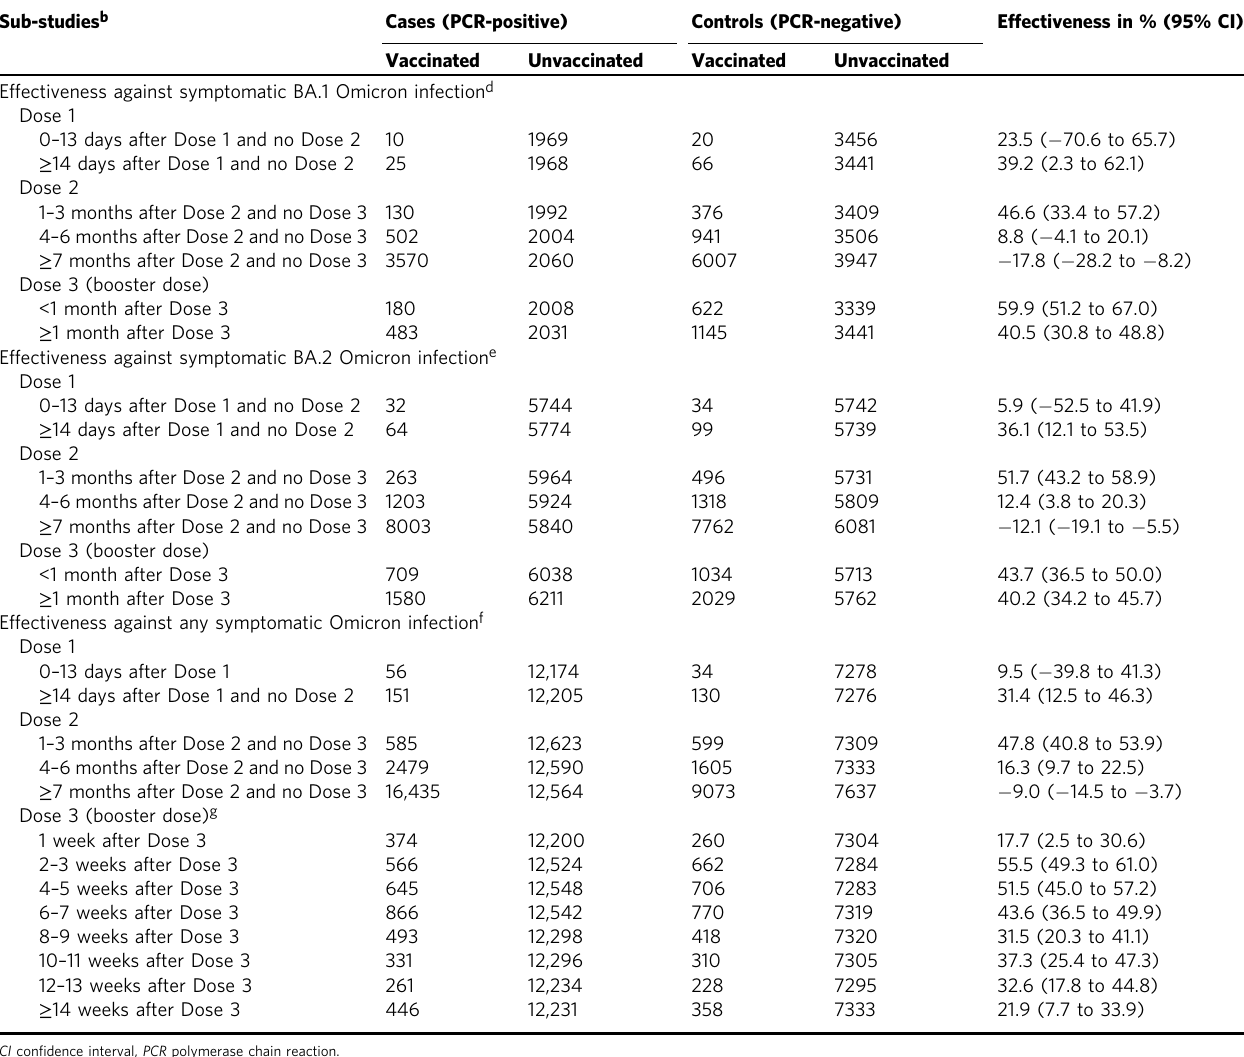
Table 3 Effectiveness of the BNT162b2 vaccine against symptomatic SARS-CoV-2 BA.1 Omicron infection, BA.2 Omicron infection, and any Omicron infection a